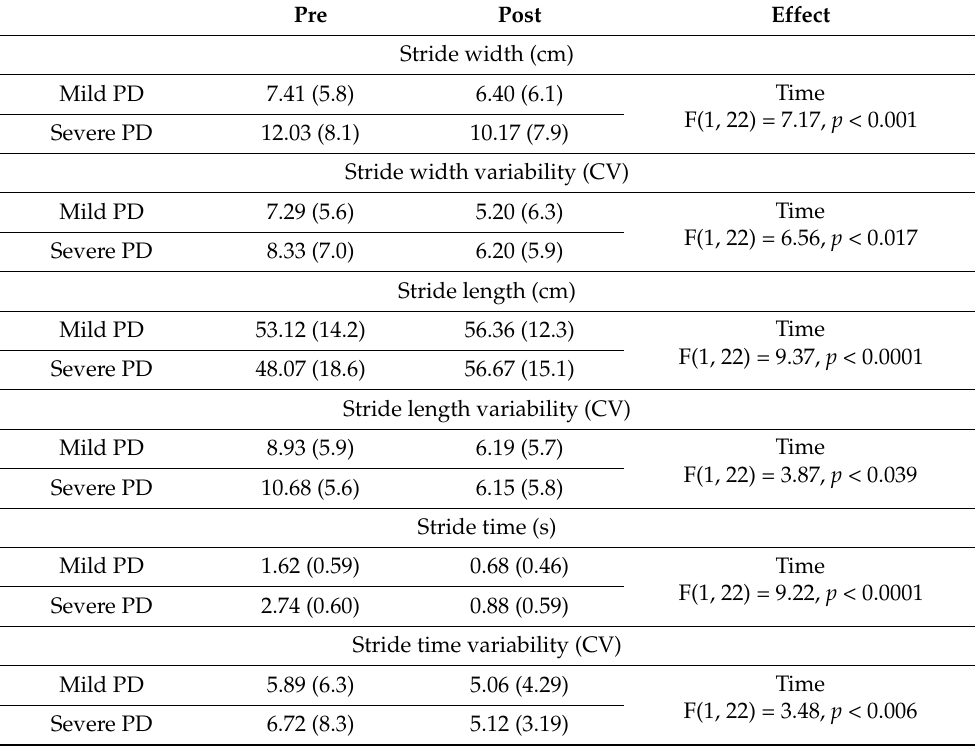
Table 2. Gait parameters closely linked to fall-risk in Parkinson’s disease (PD) before and after a 12-week PD SAFE × TM intervention (standard deviations in